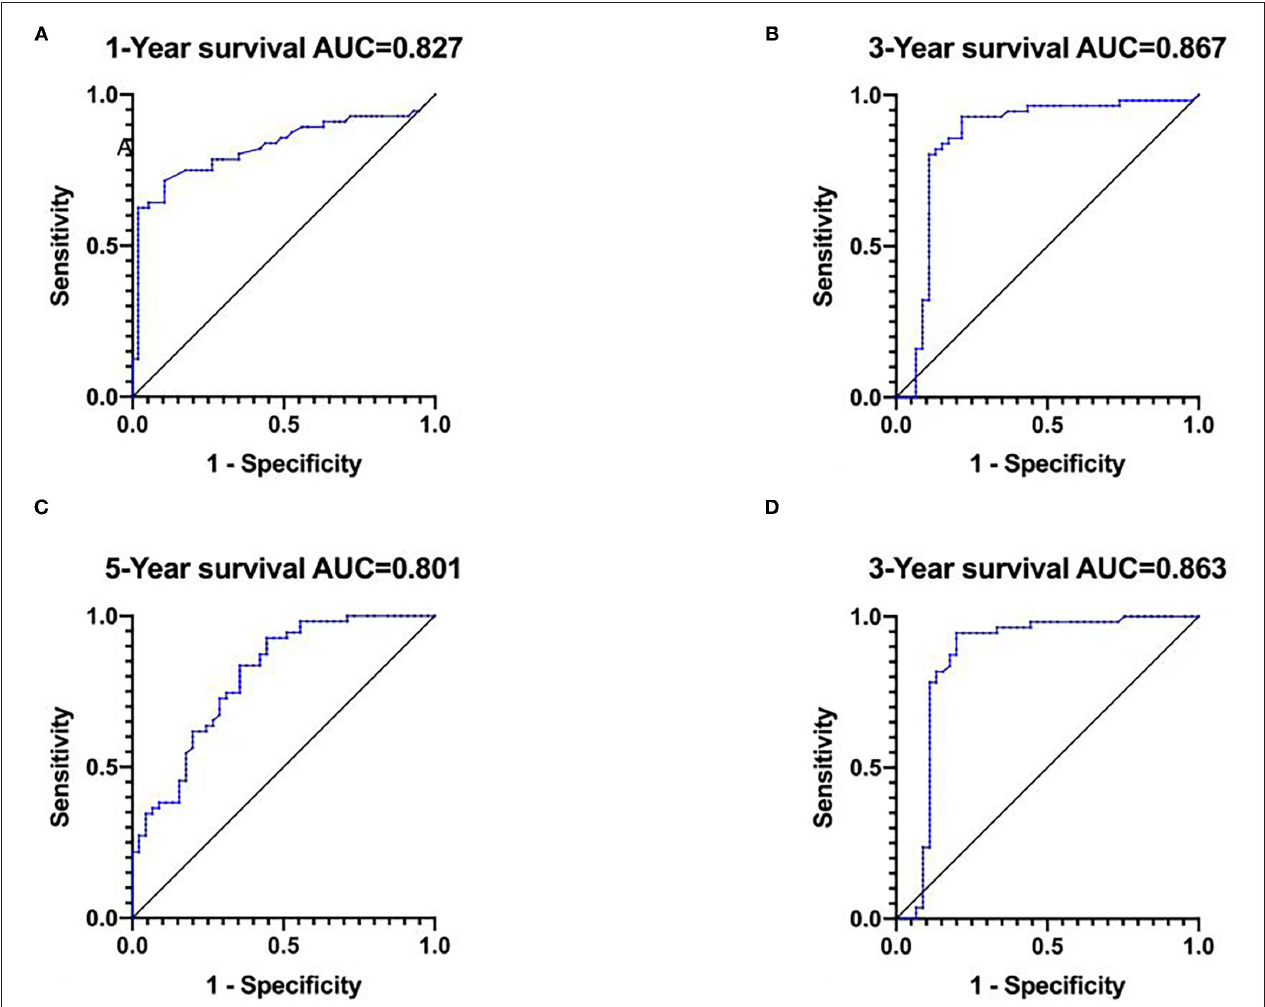
FIGURE 3 | The ROC curve for predicting patient survival at (A) 1 year, (B) 3 years, and (C) 5 years in the development cohort and at (D) 3 years in the validation